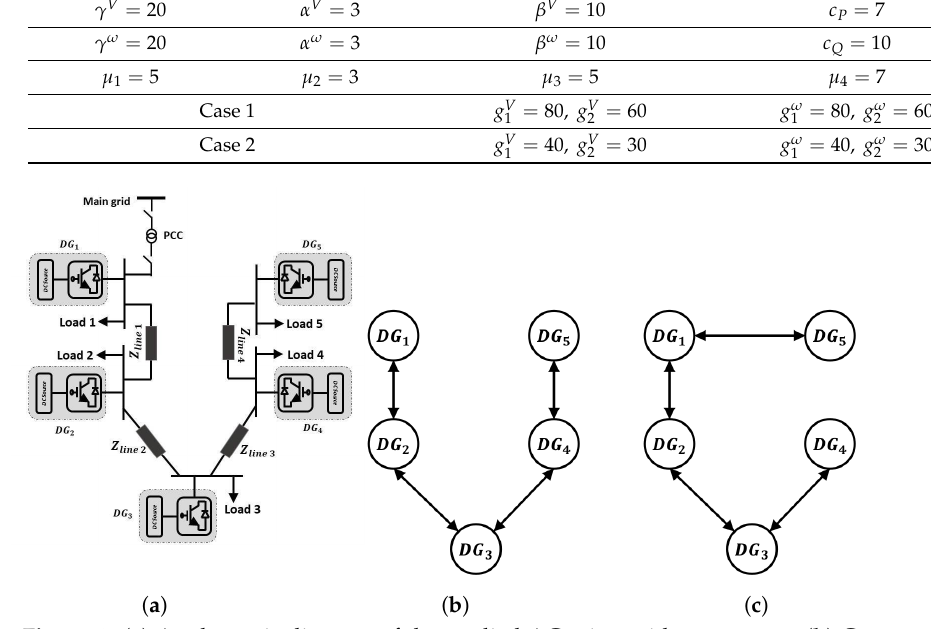
Figure 4. ( a ) A schematic diagram of the studied AC microgrid test system. ( b ) Communication graph for Section 4.1. ( c ) Communication graph for Section